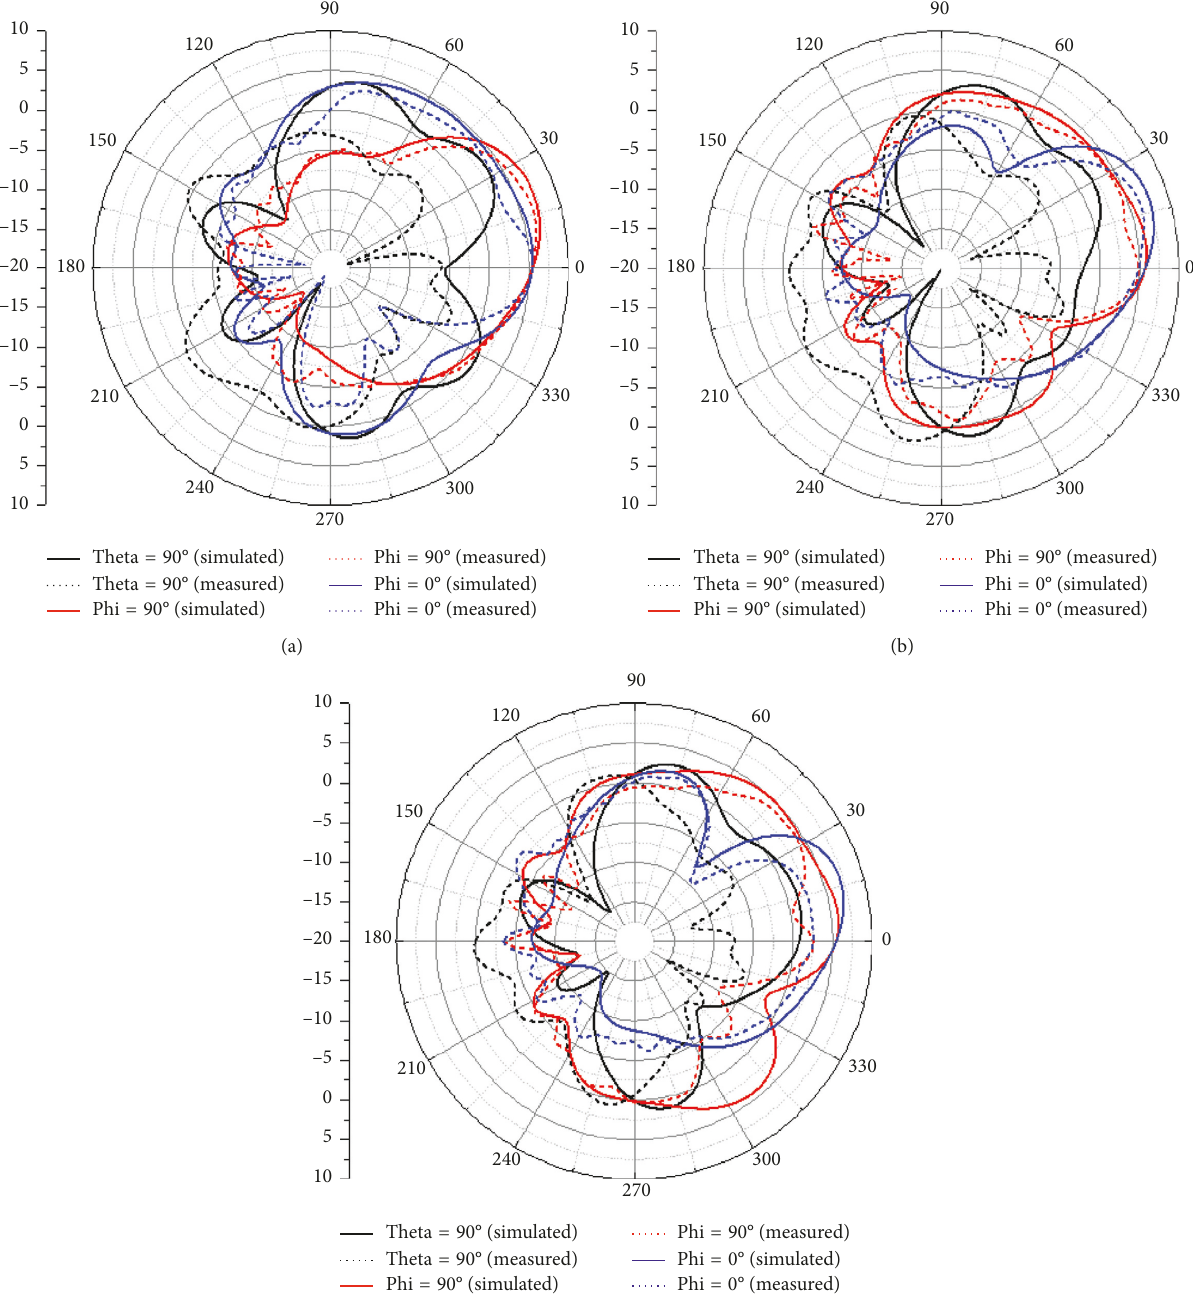
Figure 8: Measured radiation patterns in dB in free-space of the cavity-backed prototype at (a) 3.75GHz, (b) 4GHz, and (c) 4.25